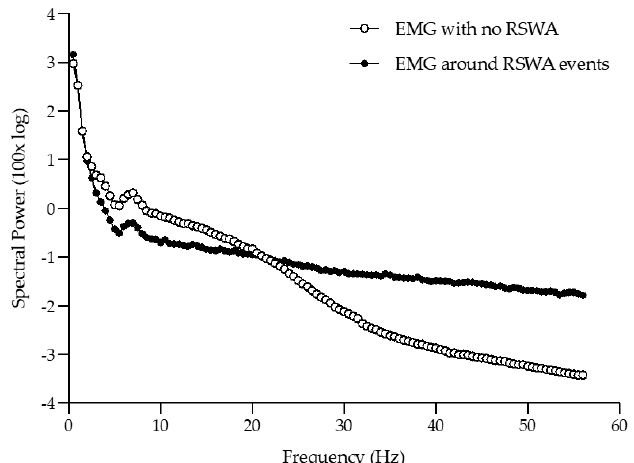
Figure 2. Overall median second-by-second EMG relative spectral power around periods of no REM sleep without atonia events and periods with an REM sleep without atonia event.